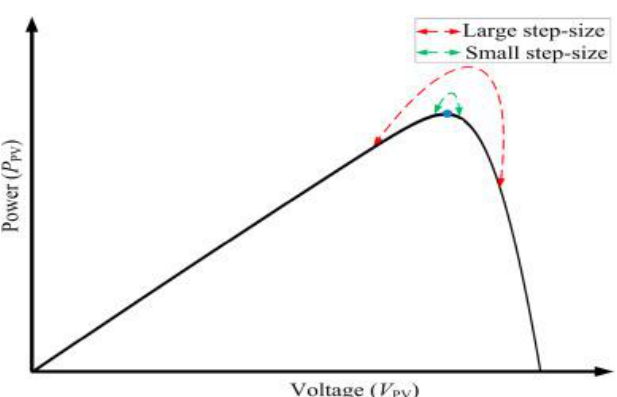
Fig. 1. Characteristic curve of a solar photovoltaic cell [7] Detecting the position of MPP is the main task, which is performed by the converter driven by an algorithm. The mostly known MPP tracking (MPPT) algorithms includes, hill climbing (HC) [10], perturb and observe (PandO) [11, 12], fractional short circuit [13], and fractional open circuit [14]. The commonly used algorithm for MPPT in the market is HC. The HC is cheap and easy to implement but the drawback of steady state oscillations could not be overcome [10]. researchers have proposed various modification and improvements in HC technique.